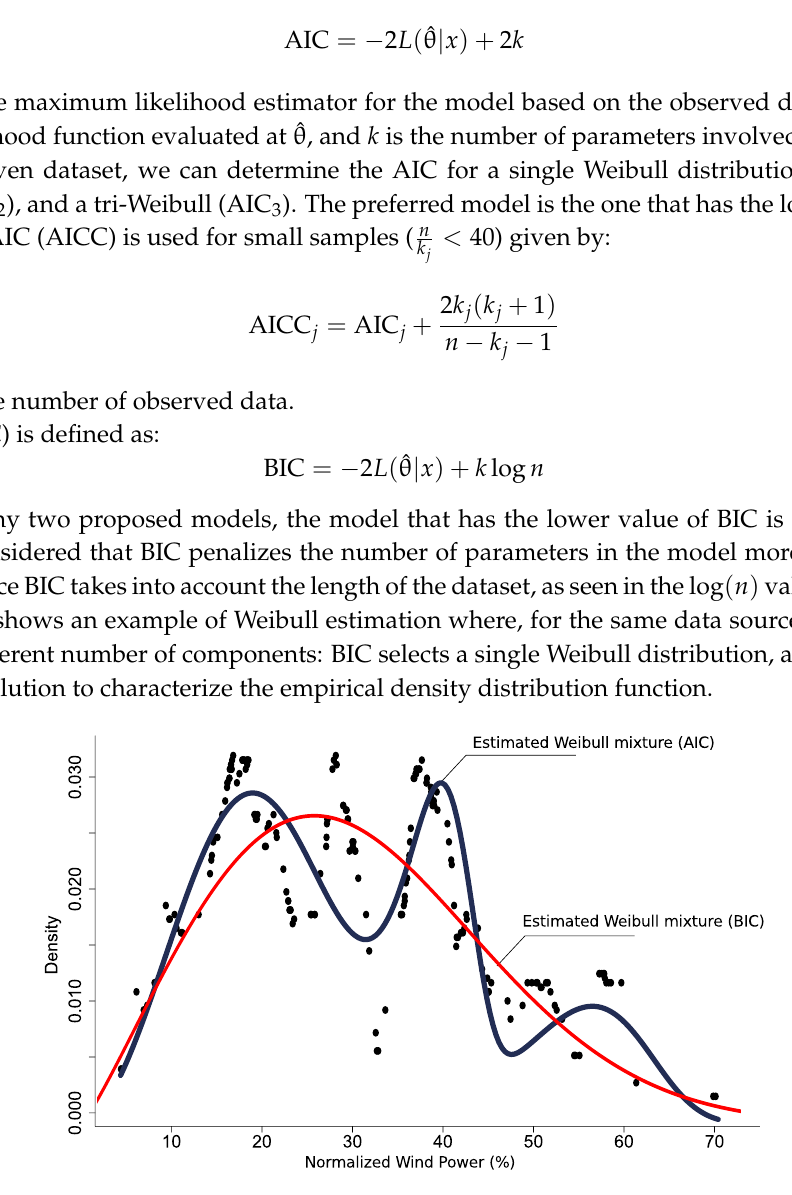
Figure 3. Example of Weibull mixture estimation for aggregated wind power generation (Bayesian information criterion (BIC) and Akaike information criterion (AIC)